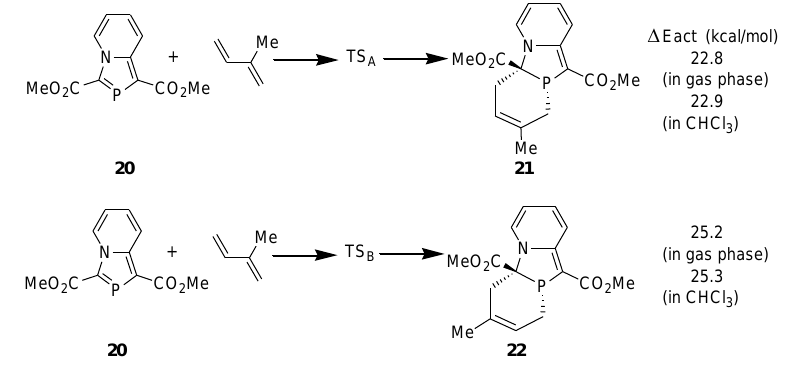
Figure 2. Model DA reactions computed at B3LYP/6-311++G**//B3LYP/6-31G**.